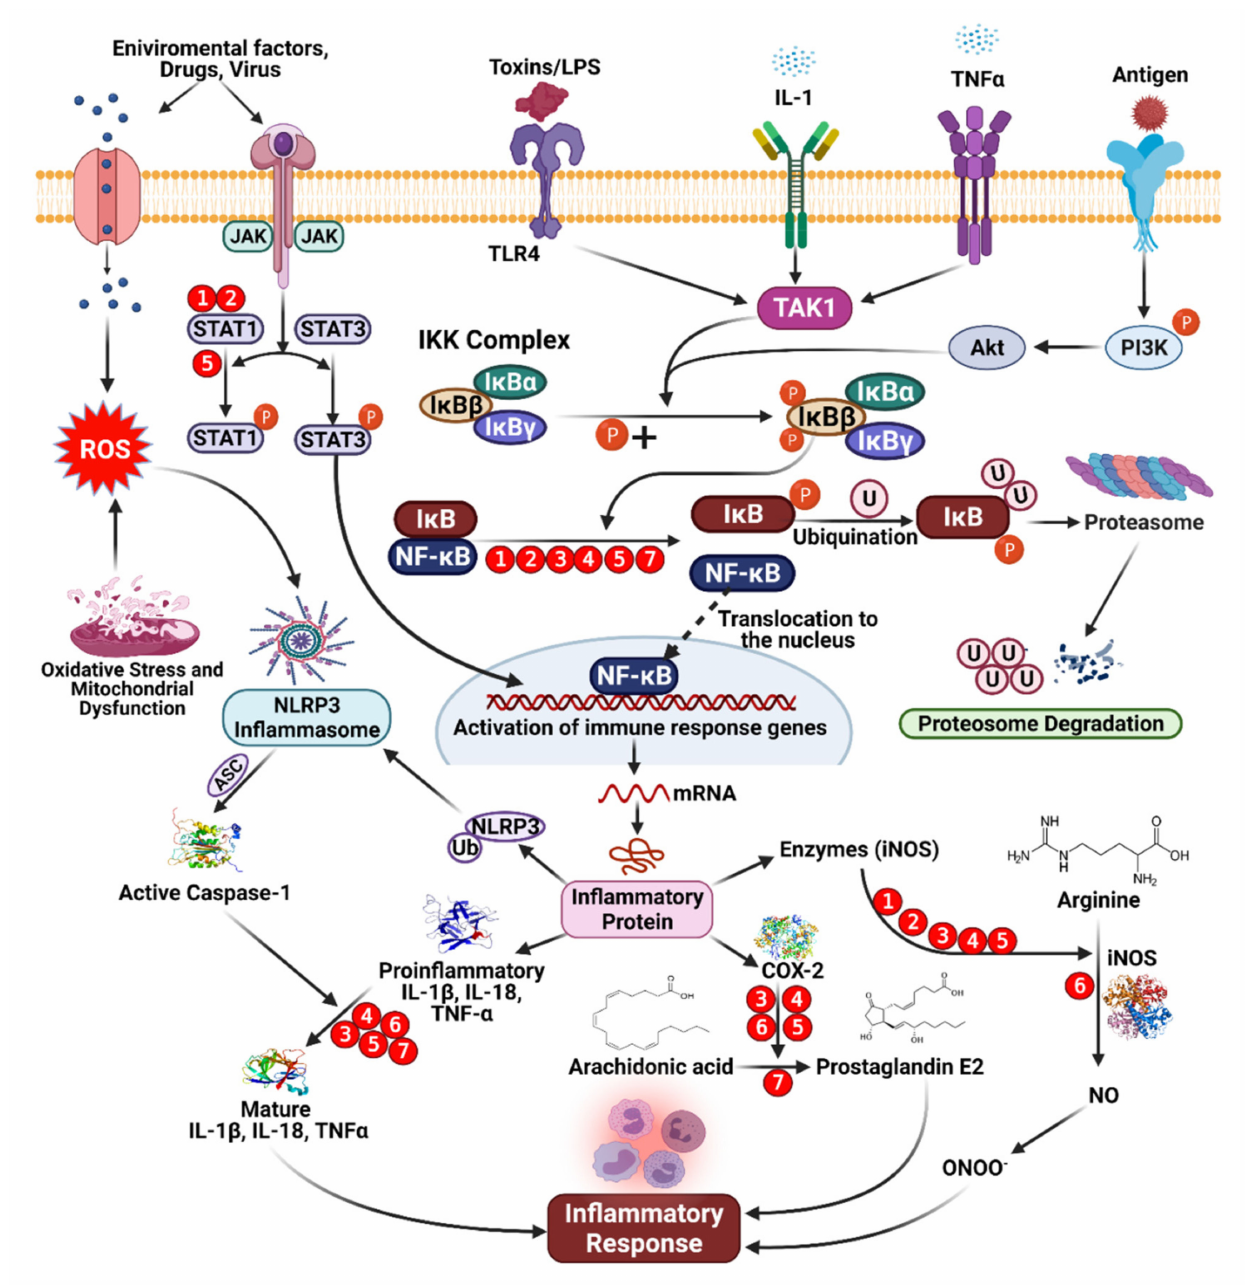
Figure 5. Mechanism of anti-inflammatory activity mediated by dietary phenolic compounds. Red circles indicate inhibition, and the numbers refer to the following phenolic